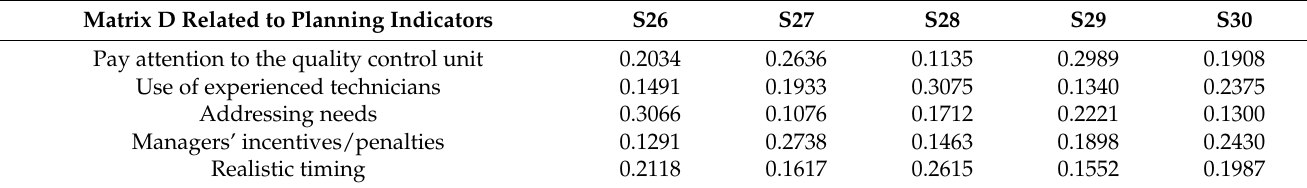
Table 24. The normalized matrix related planning indicators.